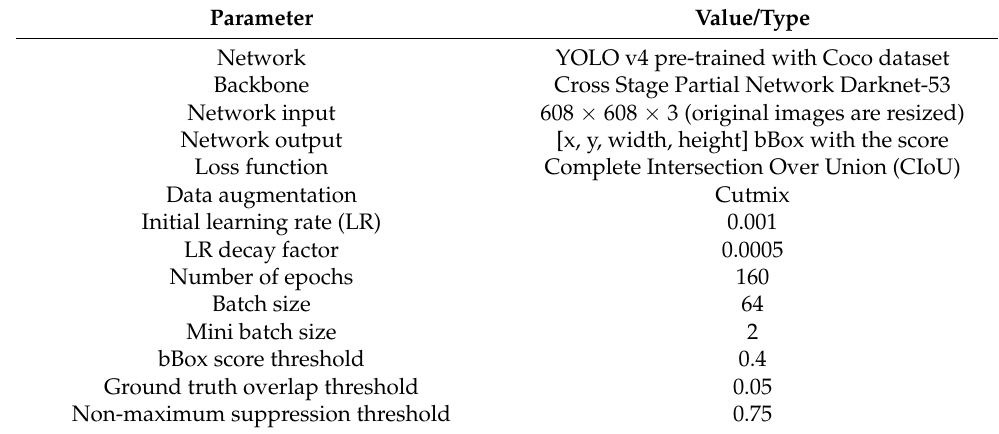
Table 6. The parameters used in the localization